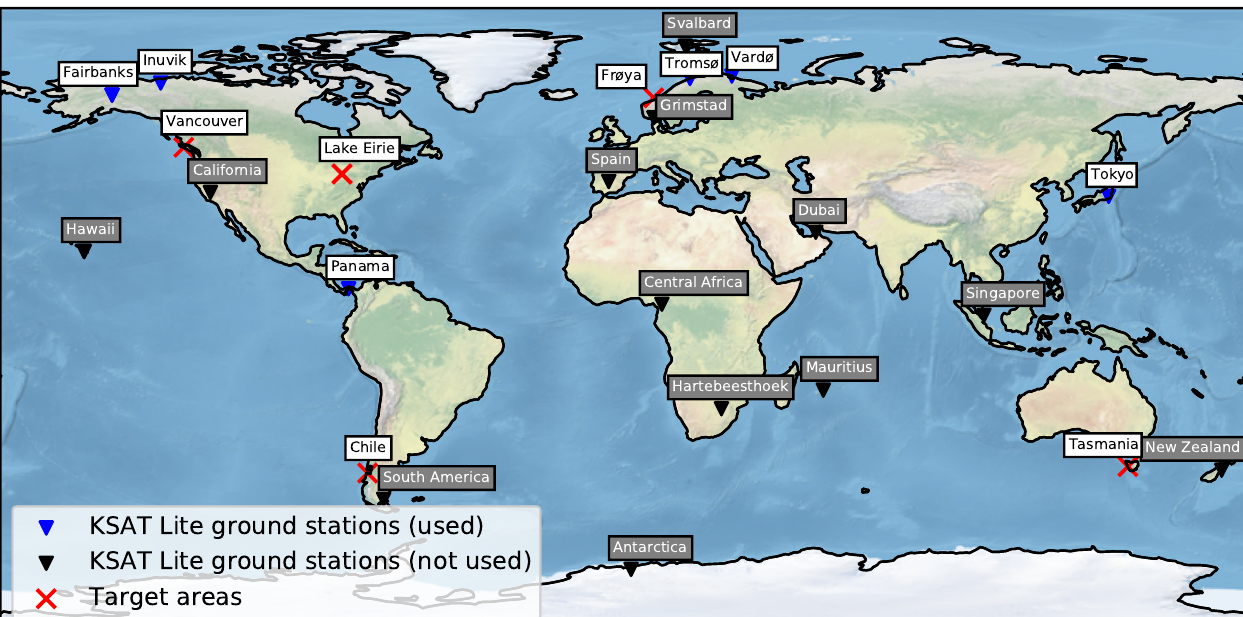
Figure 7. Areas of Interest and considered ground stations. The ground stations with blue symbols and white labels were selected by the simulator; the stations with black symbols and grey labels were available but not used. The areas of interest are indicated with a red